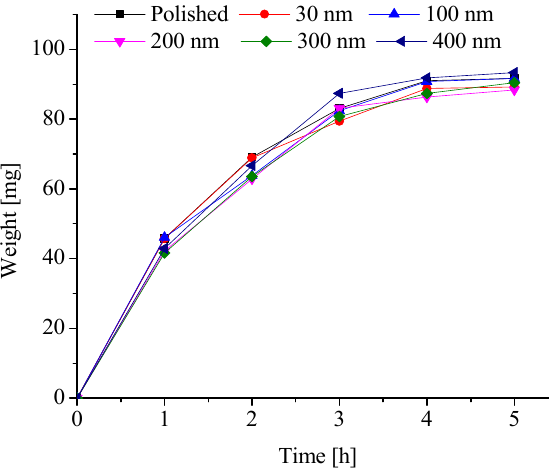
Figure 19. Variations of frost weight with different nanoporous diameters at T = − 20 °C, φ = 90%.